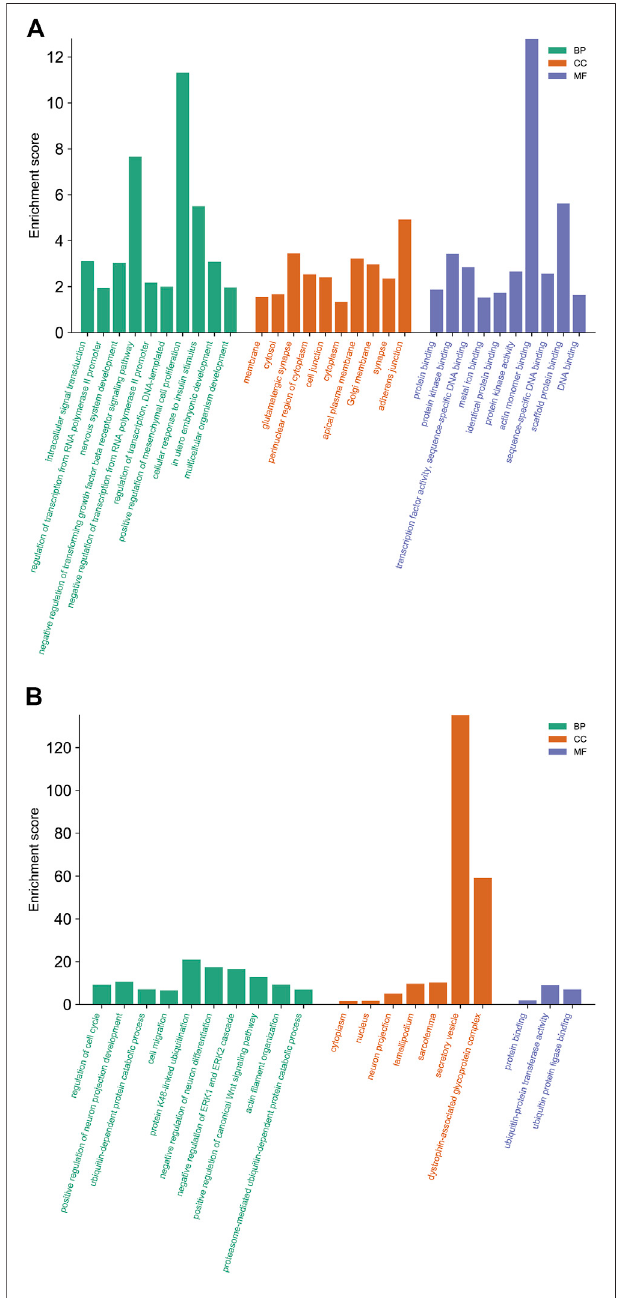
FIGURE 6 | The biological functions analysis of differential expressed miRNAs target genes. The signi fi cantly enriched GO biological processes of upregulated miRNAs (A) and downregulated miRNAs (B) . GO, Gene Ontology; BP, biological process; CC, cellular component; MF, molecular function; KEGG, Kyoto Encyclopedia of Genes and